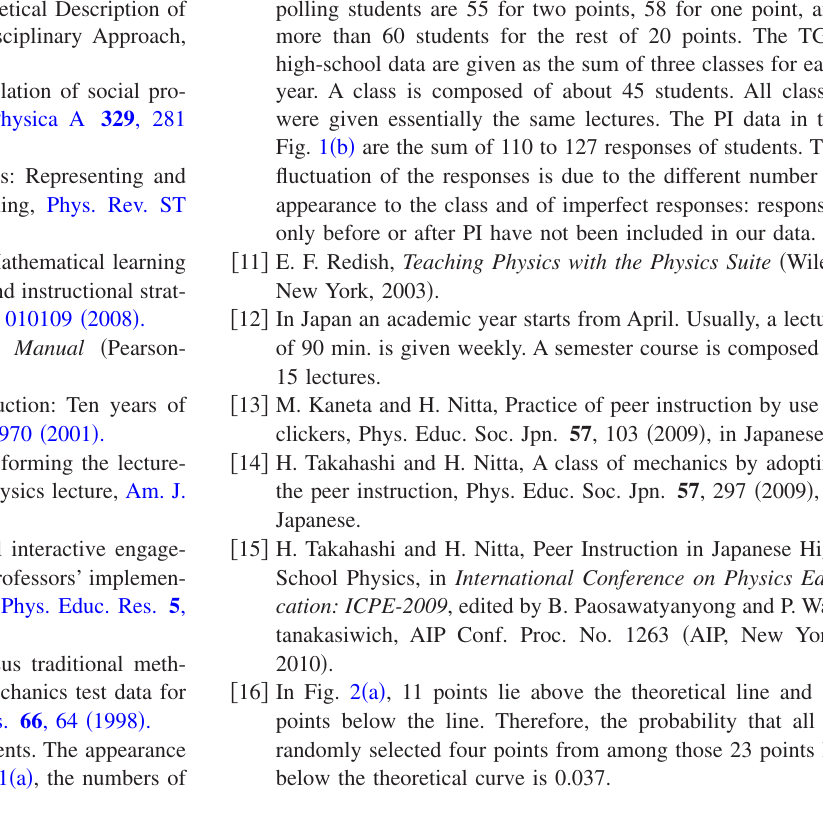
tanakasiwich, AIP Conf. Proc. No. 1263 (cid:1) AIP, New York, 2010 (cid:2) . points below the line. Therefore, the probability that all of randomly selected four points from among those 23 points lie below the theoretical curve is